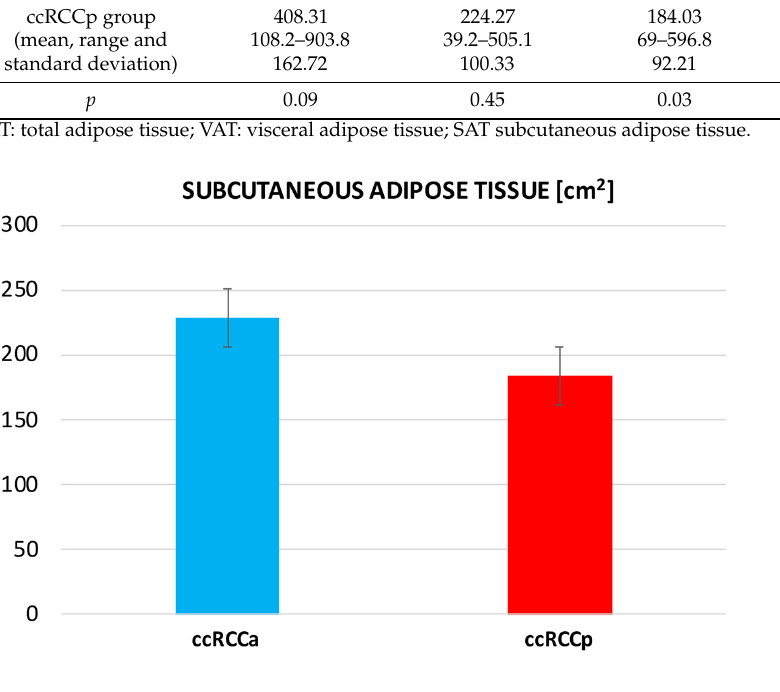
Figure 3. Bar chart showing mean values with error bars of SAT areas in ccRCCa and ccRCCp groups. Table 1. Descriptive data of ccRCCa group.